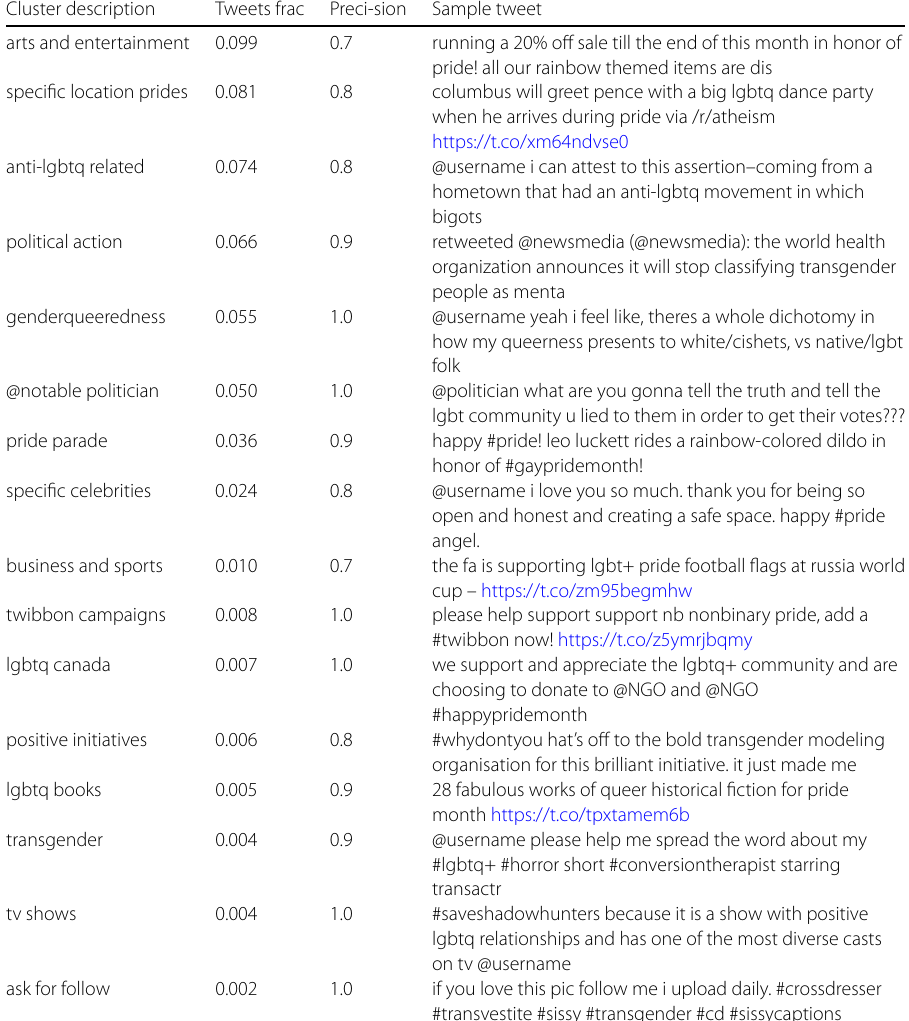
Table 2 Coherent Clusters for the LGBTQ Movement in High-activity Level. To protect privacy, we change all user handles for political elites to “@politician”, individuals to “@username”, NGOs to “@NGO”, and news organizations to “@newsmedia” Cluster description Tweets frac Preci-sion Sample tweet arts and